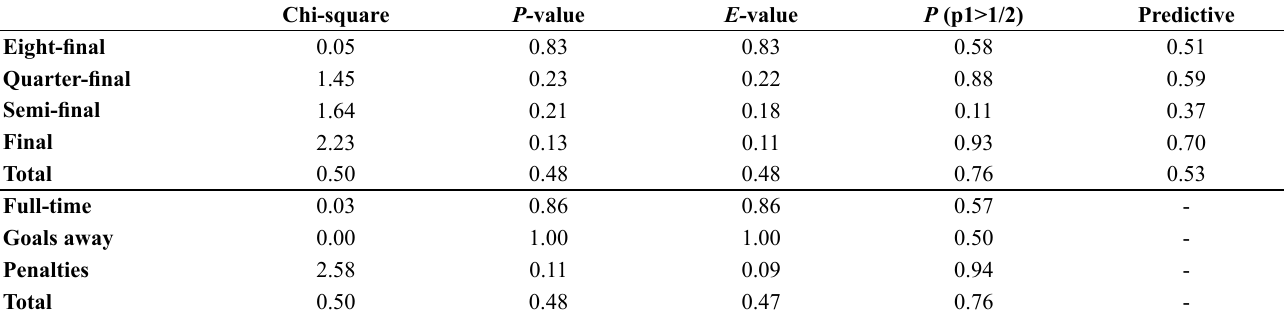
Figure 2. The relative distribution of second-leg home advantage defined by the goals away rule (Panel A) or by penalty shoot-out decisions (Panel B) during each competitive phase. Table 3. Chi-square statistic (P-value), Full Bayesian Significance Tests (E-value), probability occurrence (p1<1/2) and predictive value for comparisons between second-leg home advantages occurring according to all win forms (full-time, goals away rule and penalty-shoots) during the round of 16, quarterfinal, semi-final and final, and all matches defined as binomial “HOME” or “AWAY” results according to all win forms (full-time, goals away, and